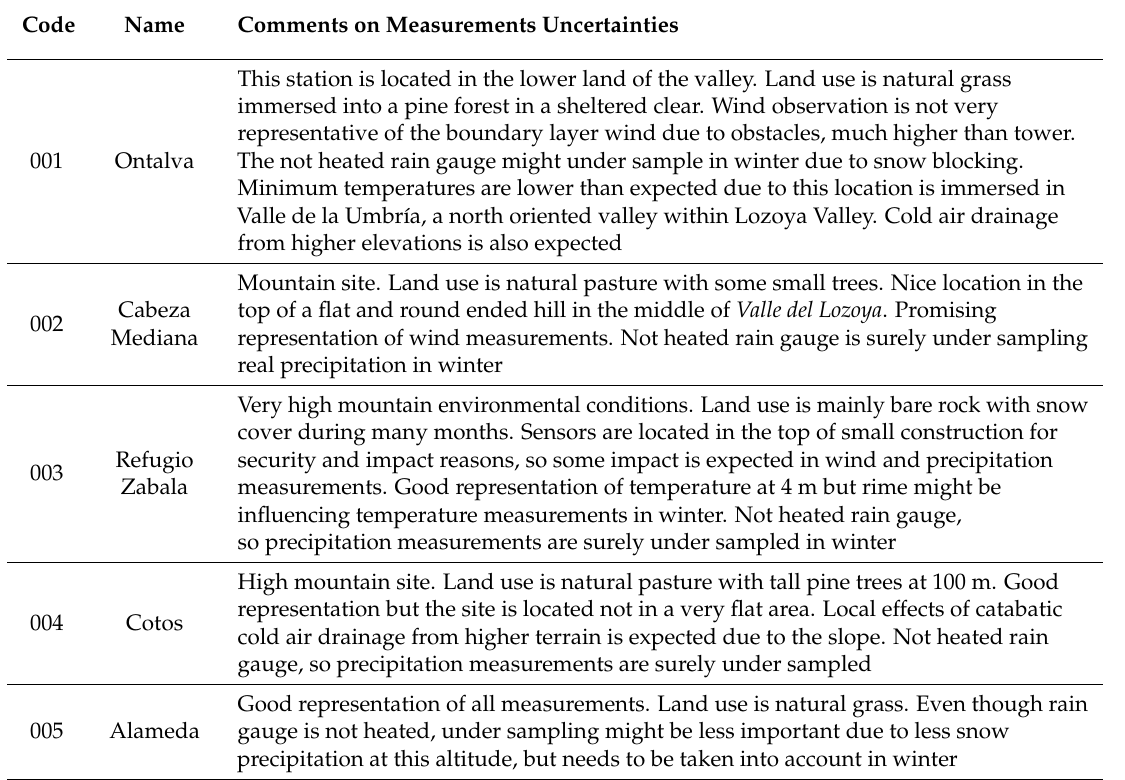
Table 2. Some comments on the completeness of the